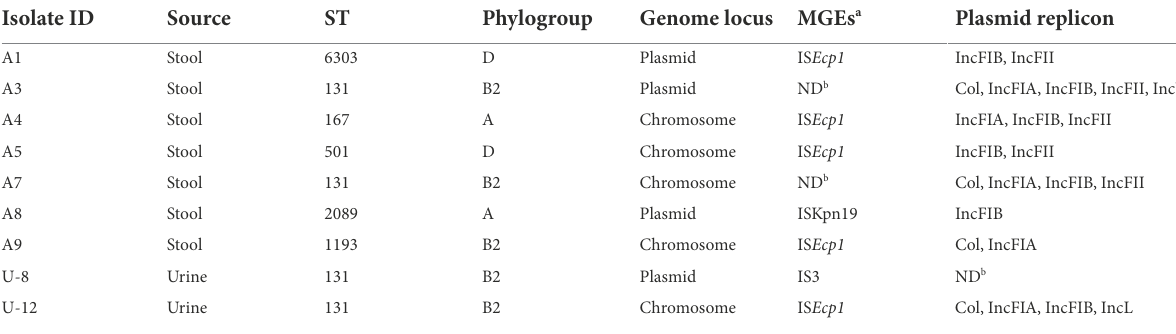
TABLE 3 Characteristics of CTX-M-15 associated NLF E. coli isolates. Isolate